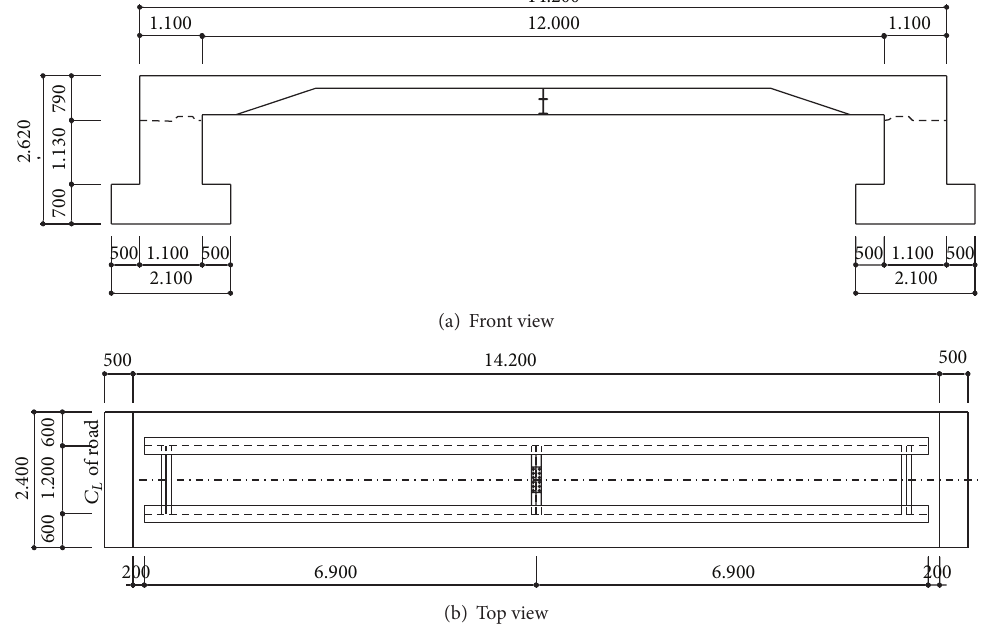
Figure 2: Layout of a test bridge.